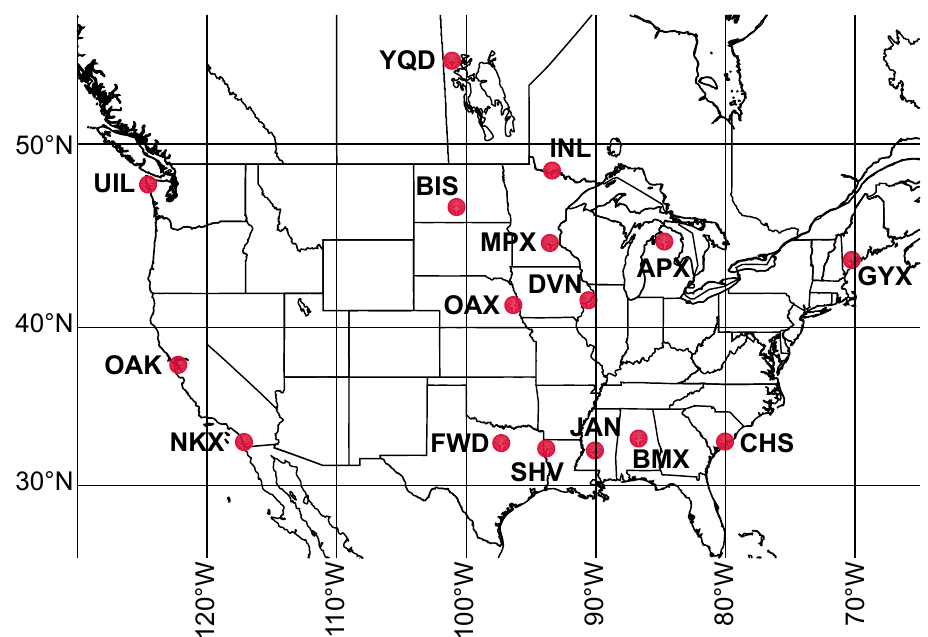
Figure 13. Map of the selected rawinsonde sites (WMO) used for model evaluation at 00 UTC (horizontal wind observations).